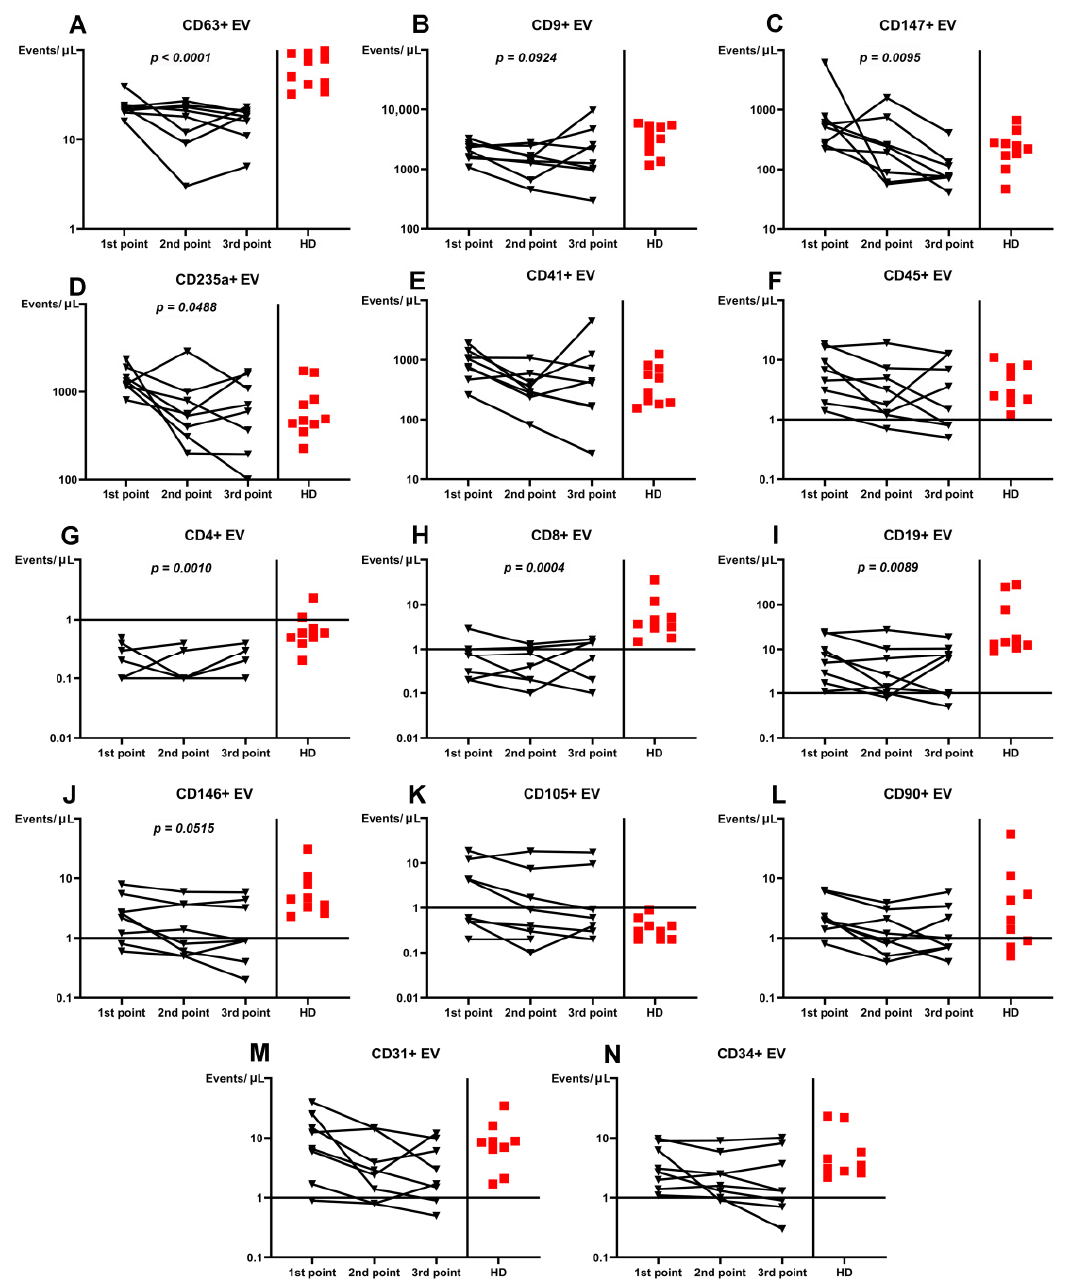
Figure 2. Dynamics in plasma concentration of extracellular vesicles (EVs) in COVID-19 patients during the treatment compared with healthy donors (HD). ( A ). CD63+ EV. ( B ). CD9+ EV. ( C ). CD147+ EV. ( D ). CD235a+ EV. ( E ). CD41+ EV. ( F ). CD45+ EV. ( G ). CD4+ EV. ( H ). CD8+ EV. ( I ). CD19+ EV. ( J ). CD146+ EV. ( K ). CD105+ EV. ( L ). CD90+ EV. ( M ). CD31+ EV. ( N ). CD34+ EV. Results represented in log10 scale.